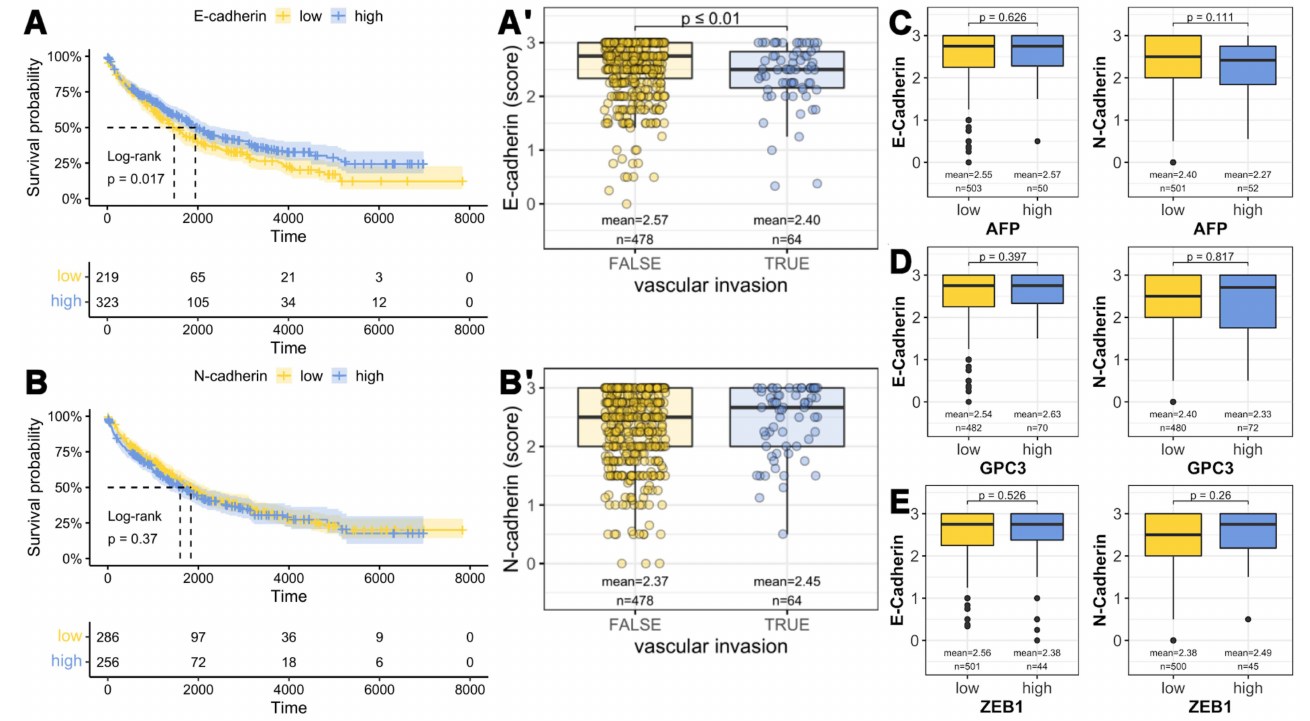
Figure 7. Kaplan–Meier overall survival in our cohort and E-/N-cadherin expression in rela- tion to prognostic factors. Stratification according to E-and N-cadherin levels (( A ), E-cadherin; ( B ), N-cadherin). Time is depicted in days. Differences in survival stratified by E-cadherin levels may be linked to significantly lower E-cadherin in HCC patients with vascular invasion ( A (cid:48) ), while for N-cadherin, no significant association was detected ( B (cid:48) ). With immunohistochemistry, no association of prognostically relevant proteins such as AFP ( C ) and GPC3 ( D ) ZEB1 ( E ), a prognostic marker associated with EMT, was found with E- or